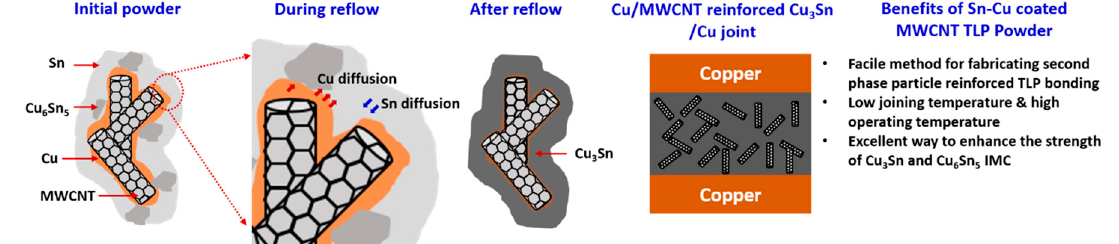
Figure 4. Schematic illustrating the mechanism of Cu 3 Sn-MWCNT formation during TLP bonding.